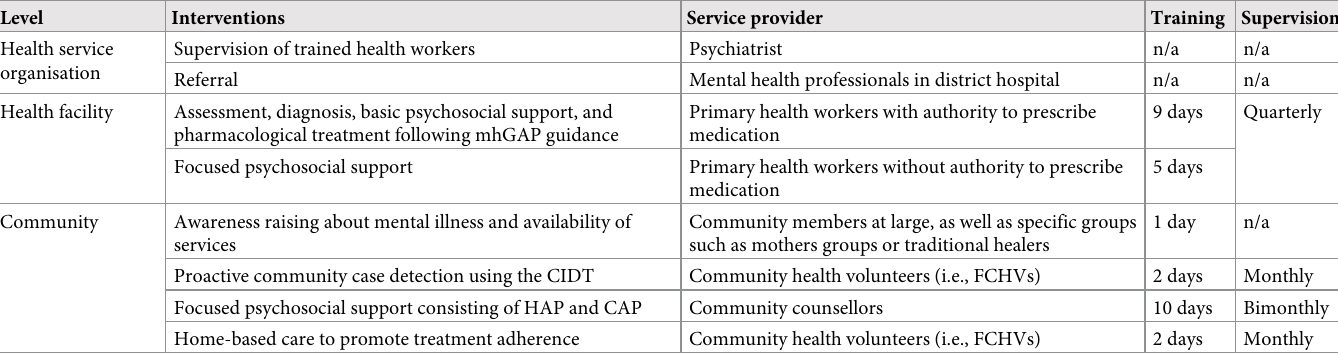
Table 1. Overview of the district mental healthcare plan.